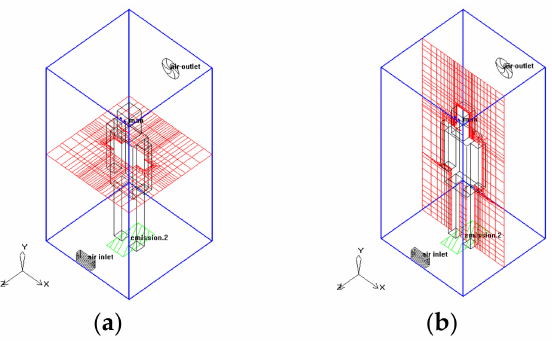
Figure 6. Structured mesh of computational domain: ( a ) XZ plane view; ( b ) XY plane view.